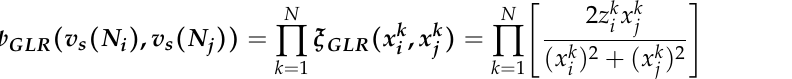
Figure 2. The similarity value ξ GLR ( x k and x k . ( b ) The similarity when x k j